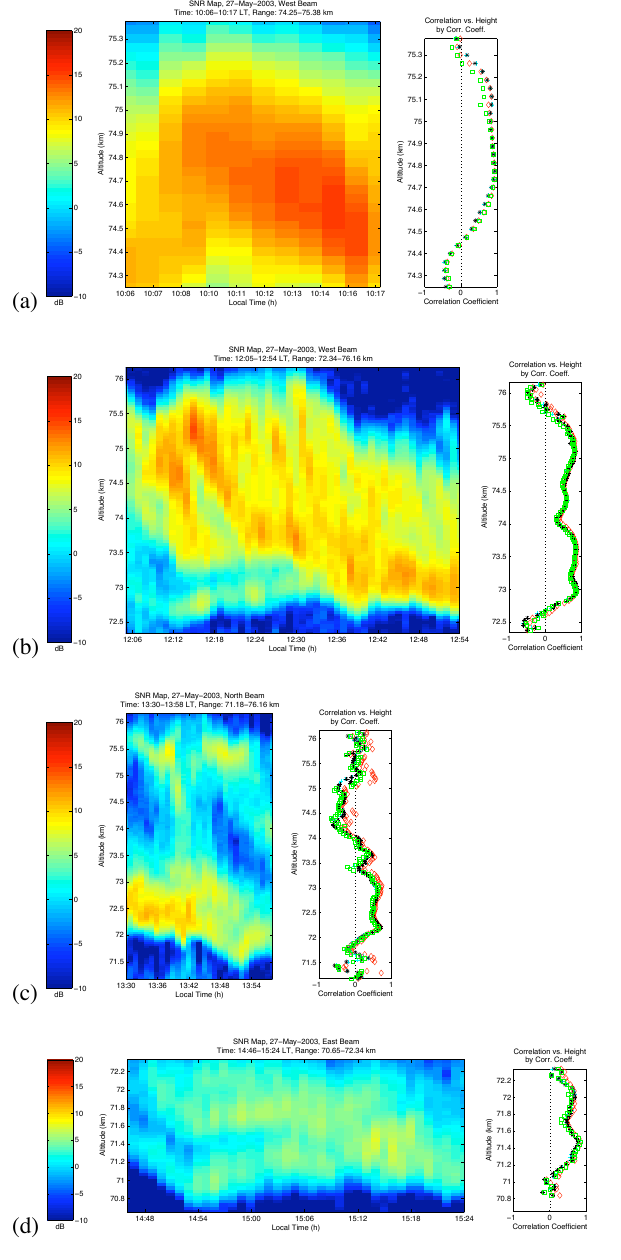
Fig. 5. SNR maps and correlation plots of sections of the turbulent layer at 74 km on May 27 at (a) 09:54 LT, (b) 12:08 LT, (c) 13:30 LT, and (d) 14:50 LT.